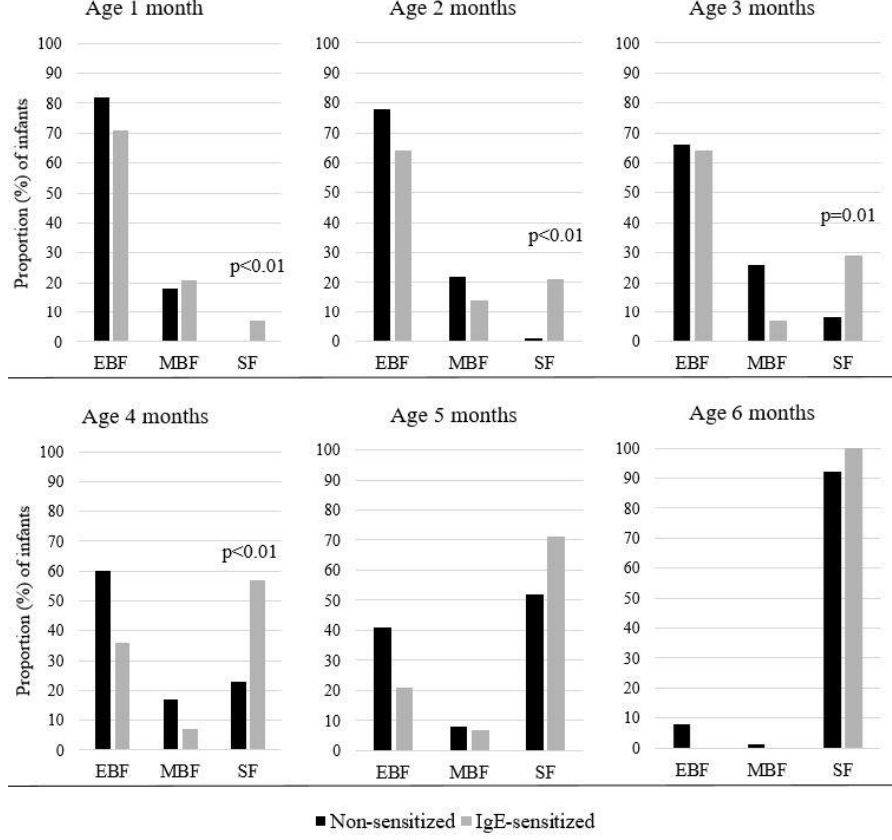
Figure 1. Proportion (%) of infants aged 1–6 months receiving exclusively breastmilk (EBF); mixed breastmilk and infant formula or exclusively infant formula (MBF); or any solid food (SF), shown for non-sensitized ( n = 130) and IgE sensitized children ( n = 14). Total vitamin D intake at 12 months was lower among IgE sensitized than non-sensitized children, presented as median (25th, 75th percentiles): 3.9 μg/d (3.2, 7.2) vs. 8.1 μg/d (4.4, 12.3), respectively, p = 0.03. This could partly be explained by less but non-significant vitamin D supplement use among IgE sensitized children (see Figure 2) and partly by less consumption of vitamin D fortified formula (consumed by 30% of IgE sensitized vs. 68% of non-sensitized children at 12 months, p = 0.02). Higher vitamin D intake at 12 months was associated with a decreased odds for sensitization, OR = 0.8 (95%, CI = 0.7 – 0.996) when adjusted for maternal smoking. As shown in Figure 2, IgE sensitized children were less likely than non-sensitized children to use vitamin D supplements at 6 years of age (23% vs. 56%, p = 0.03). Vitamin D supplement use at 6 years was associated with a decreased odds for sensitization, OR = 0.2 (95%, CI = 0.1 – 0.98), when adjusted for maternal smoking. The median intake of vitamin D at 6 years was 3.1 μg/d (2.1, 3.6) vs. 5.3 μg/d (2.3, 12.4) among IgE sensitized vs. non-sensitized children, respectively (NS, p = 0.09). Mean serum 25(OH)D did not differ between IgE sensitized and non-sensitized children, at either 12 months (96.8 ± 33.6 vs. 99.3 ± 32.2 nmol/L, respectively) or 6 years (59.3 ± 15.9 vs. 56.0 ± 16.7 nmol/L, respectively). It should be noted that only half of participants had serum 25(OH)D measured at 12 months (69 non-sensitized and 7 IgE sensitized).